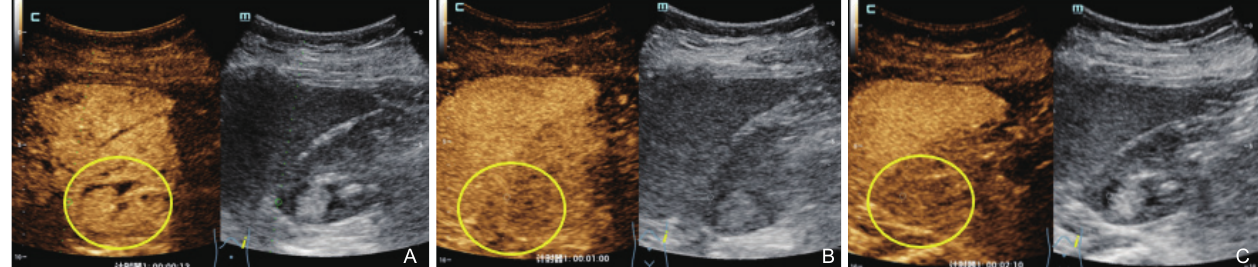
Figure 3 In a 40-year-old female, an echogenic nodule measuring 1.7 × 1.4 cm was detected in the left kidney, with a clear boundary and regular shape. After intravenous injection of the ultrasound contrast agent SonoVue, the nodule demonstrated slightly hyperenhancement in the cortical phase (A) and medullary phase (B). The delayed phase (C) showed isoenhancement. The pathology report confirmed a chromophobe renal carcinoma.